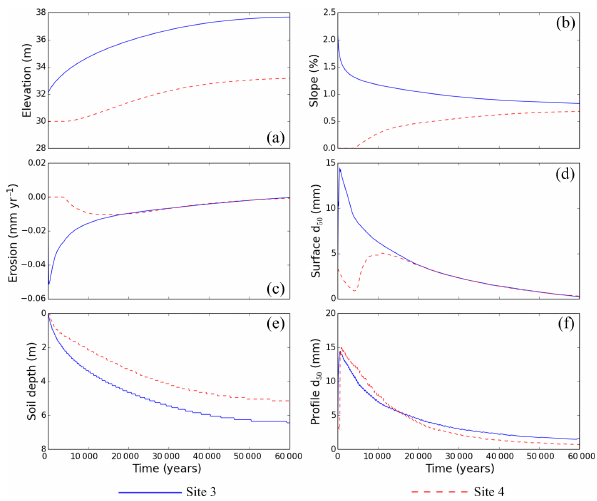
Figure 8. Evolution (near the hillslope–valley boundary) of sites 3 and 4: (a) elevation, (b) hillslope gradient, (c) erosion rate, (d) sur- face d 50 , (e) soil depth, and (f) profile d 50